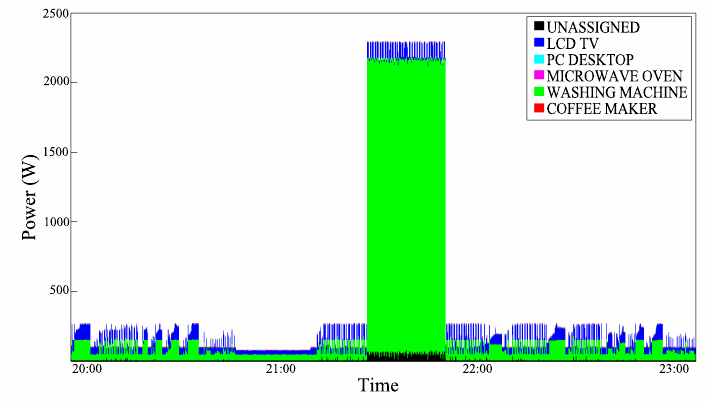
Figure 11. Power consumption disaggregation obtained with the UP Double Interval Conditioning